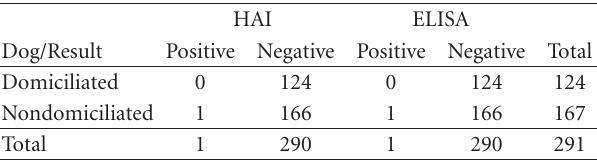
Table 1: Serology test results from